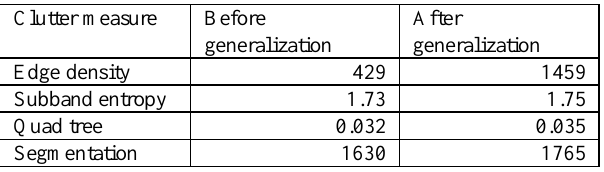
Table 2. Clutter increases due to blank